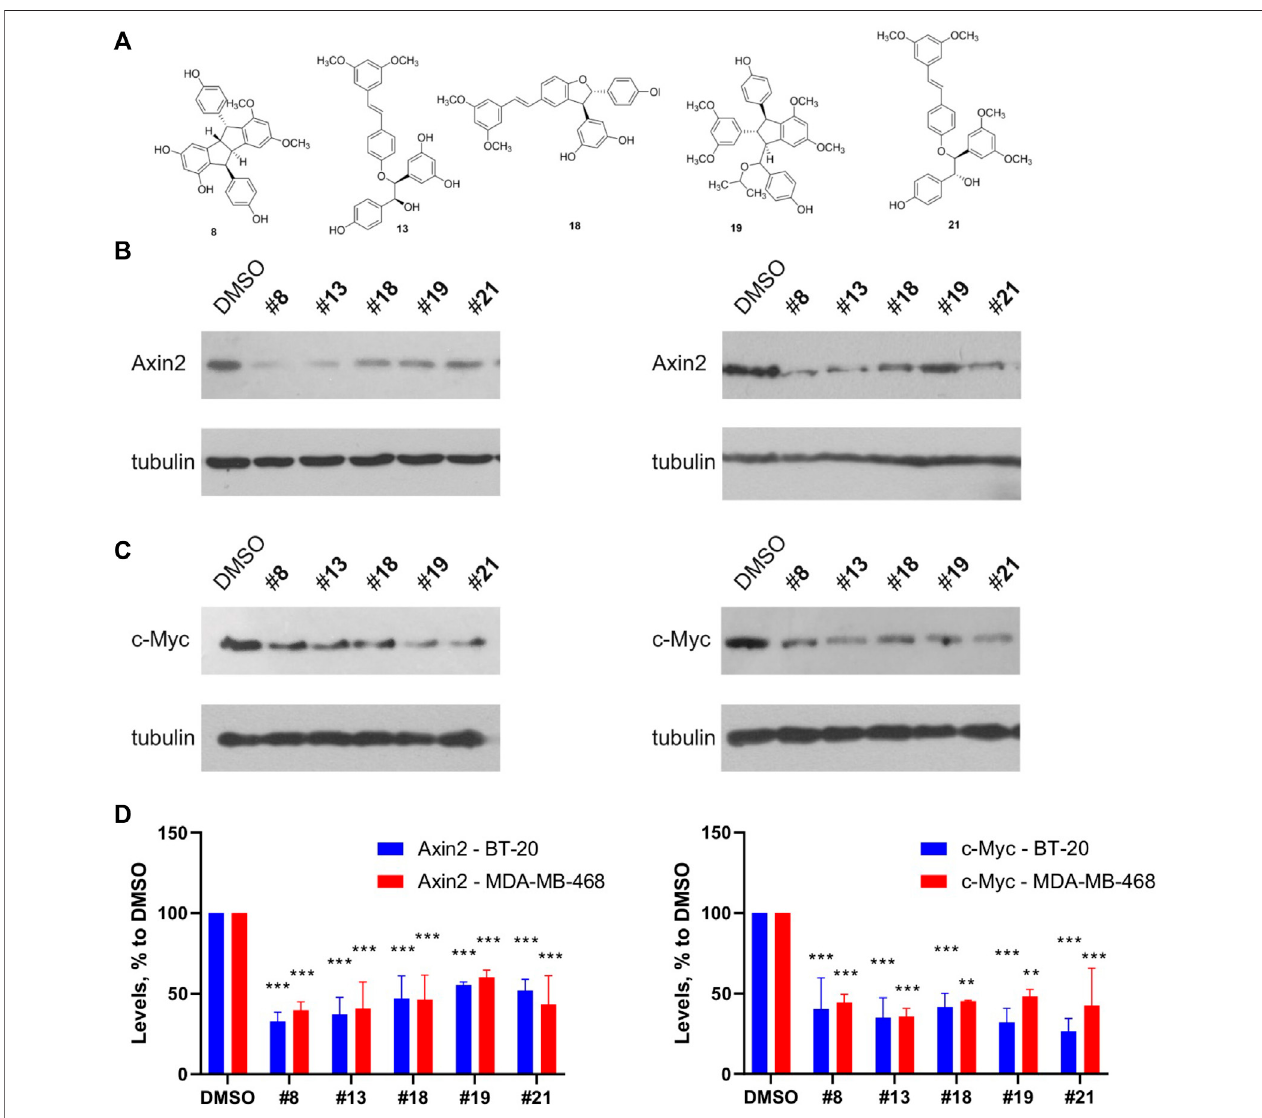
FIGURE9| Representativecompoundsfromthedifferentstructuralgroupsofthederivatives (A) inhibitexpressionofthebasallevelsofWnttargetgenesAxin2 (B) and c-Myc (C) in the TNBC cell lines BT-20 (left) and MDA-MB-468 (right). Quanti fi cation of the Western blots is presented on (D) . Statistical signi fi cance was assessed by two-way ANOVA followed by multiple comparisons with DMSO-treated values, p values are shown as ** p < 0.01, *** p < 0.001.